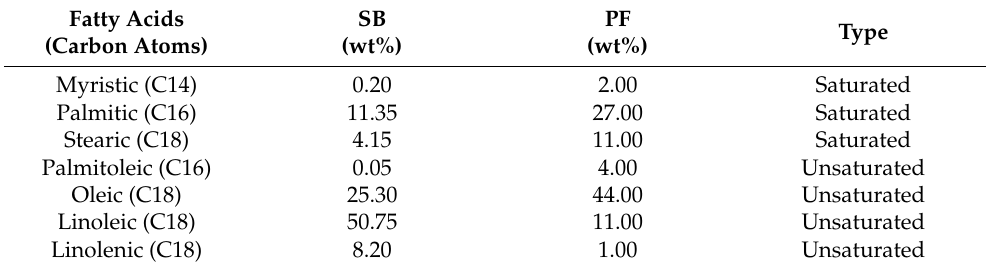
Table 1. Percentage of fatty acids present in the SB/PF used to synthesize the anionic surfactant. Fatty